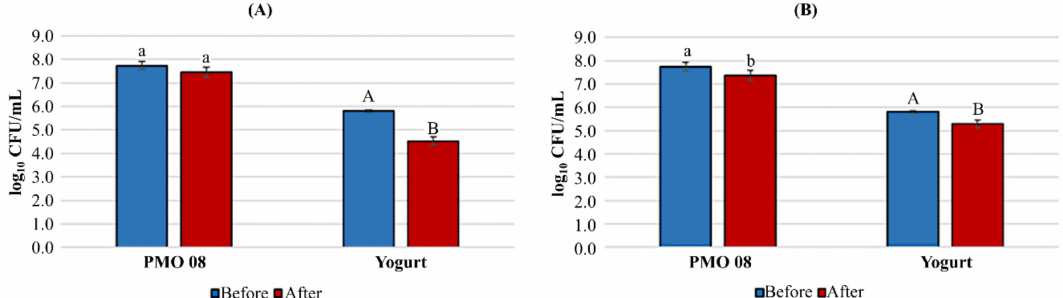
Figure 3. Viability of fermented beverages in the artificial gastrointestinal juice. ( A ) Artificial